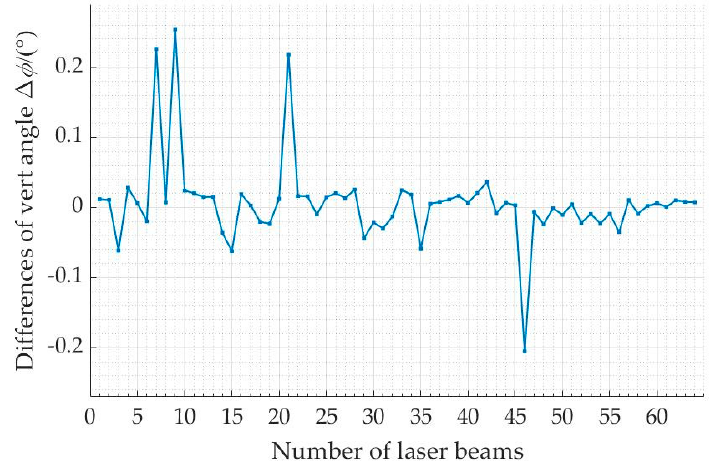
Figure 17. Differences in vertical angle ∆ ϕ i .